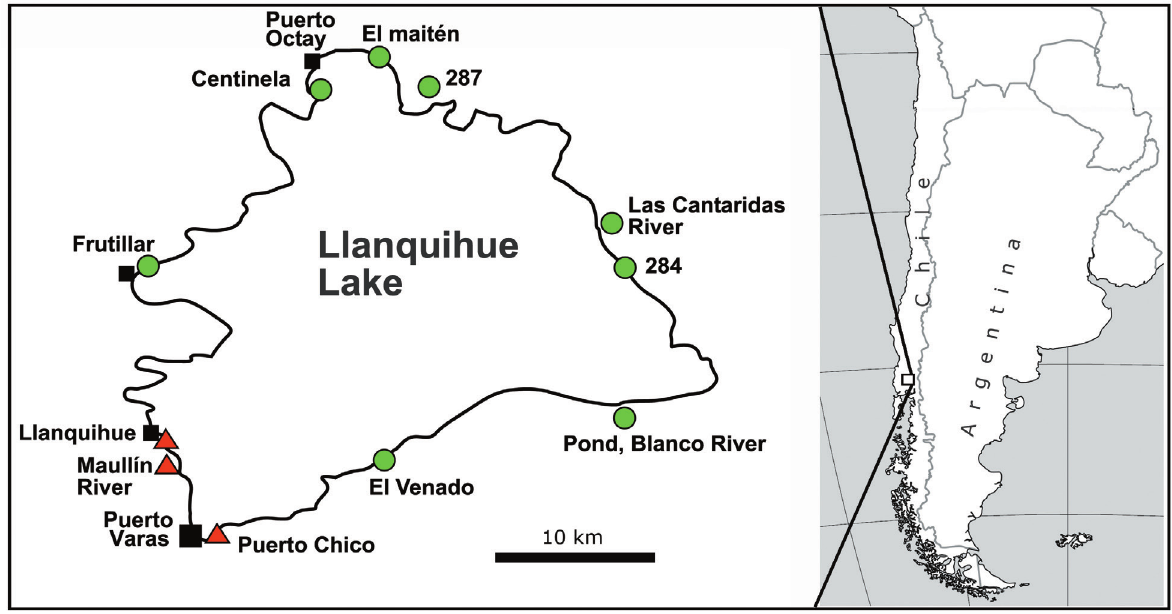
Figure 1. Sampling localities in Llanquihue Lake. Physa acuta was found in three places (red triangles). Negative sampling sites for the species are shown in green circles. Principal cities are depicted by black